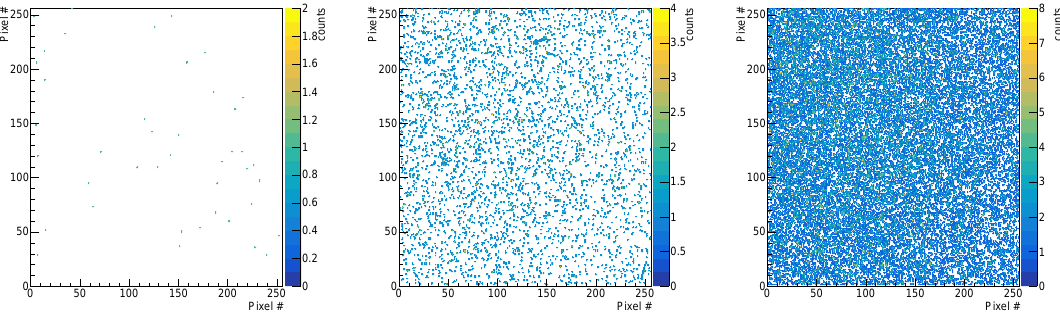
Figure 11. The ultra-low proton fluxes at the U-120M cyclotron for various ion source discharge currents. Timepix collection time 30 seconds, bias 5 V. Left: The ion source off, flux ∼ 0.7 proton · cm − 2 · s − 1 . Middle: The discharge current 60 µ A, flux ∼ 60 proton · cm − 2 · s − 1 . Right: The discharge current 200 µ A, flux ∼ 420 proton · cm − 2 · s − 1 . Figure taken from